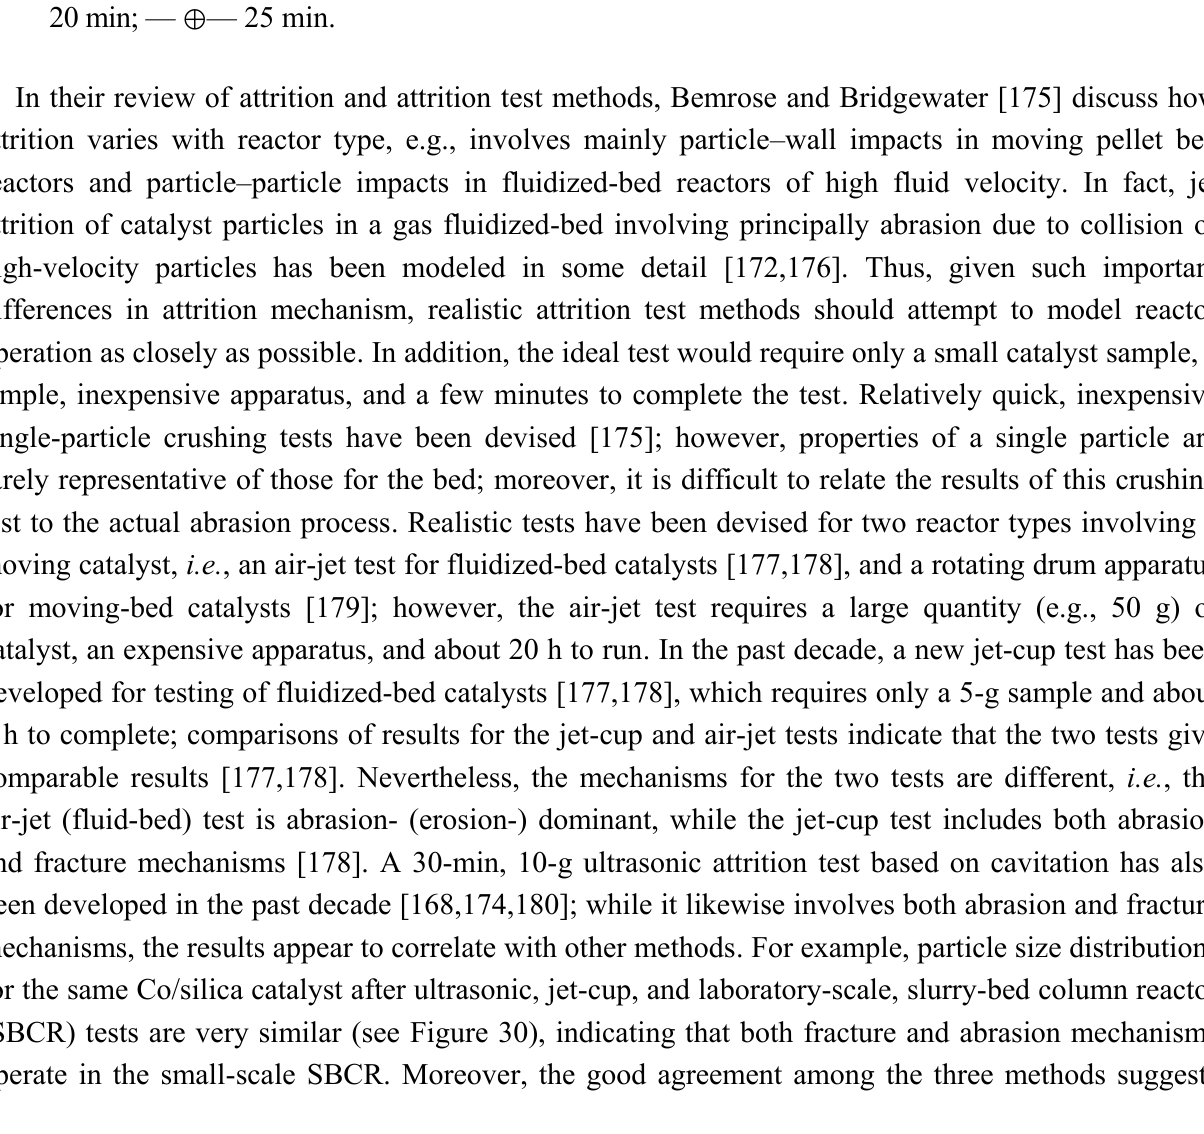
Figure 29. Sedigraph particle size distributions of a precipitated Fe–Cu catalyst, as-prepared and after spray-drying. The as-prepared catalyst ( a ) is weak and breaks down easily after 25 min of ultrasonic irradiation, while spray-drying ( b ) improves its attrition resistance. Reproduced from [174]. Copyright 2000, Elsevier. — □— 0 min; ♦ 5 min; — ○— 10 min; —Δ— 15 min; —  — 20 min; — ⊕ — 25